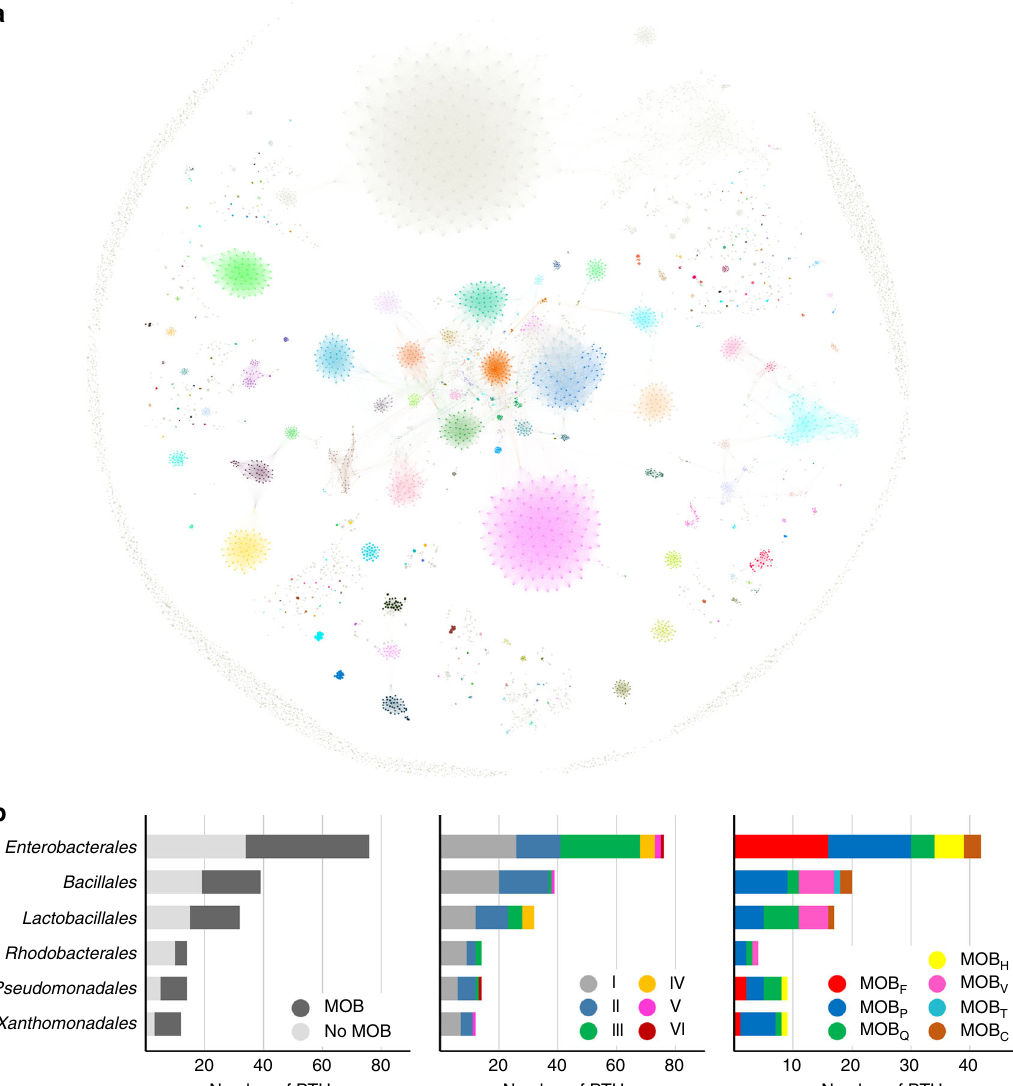
Fig. 6 PTUs identi fi ed in the entire bacterial plasmidome. a A colormap of the PTUs identi fi ed by PID in the ANI L50 network of the entire bacterial plasmidome, retrieved from RefSeq84. Plasmids are colored by PTU membership. A comprehensive list of all PTUs and their members can be found in Supplementary Data 2. Source data are provided as a Source Data fi le. b Characteristics of PTUs found in the six more abundant orders. The leftmost panel indicates the proportion of MOB + and MOB − PTUs. The panel in the middle indicates the host range distribution (Grade I – VI). The rightmost panel shows the distribution of MOB